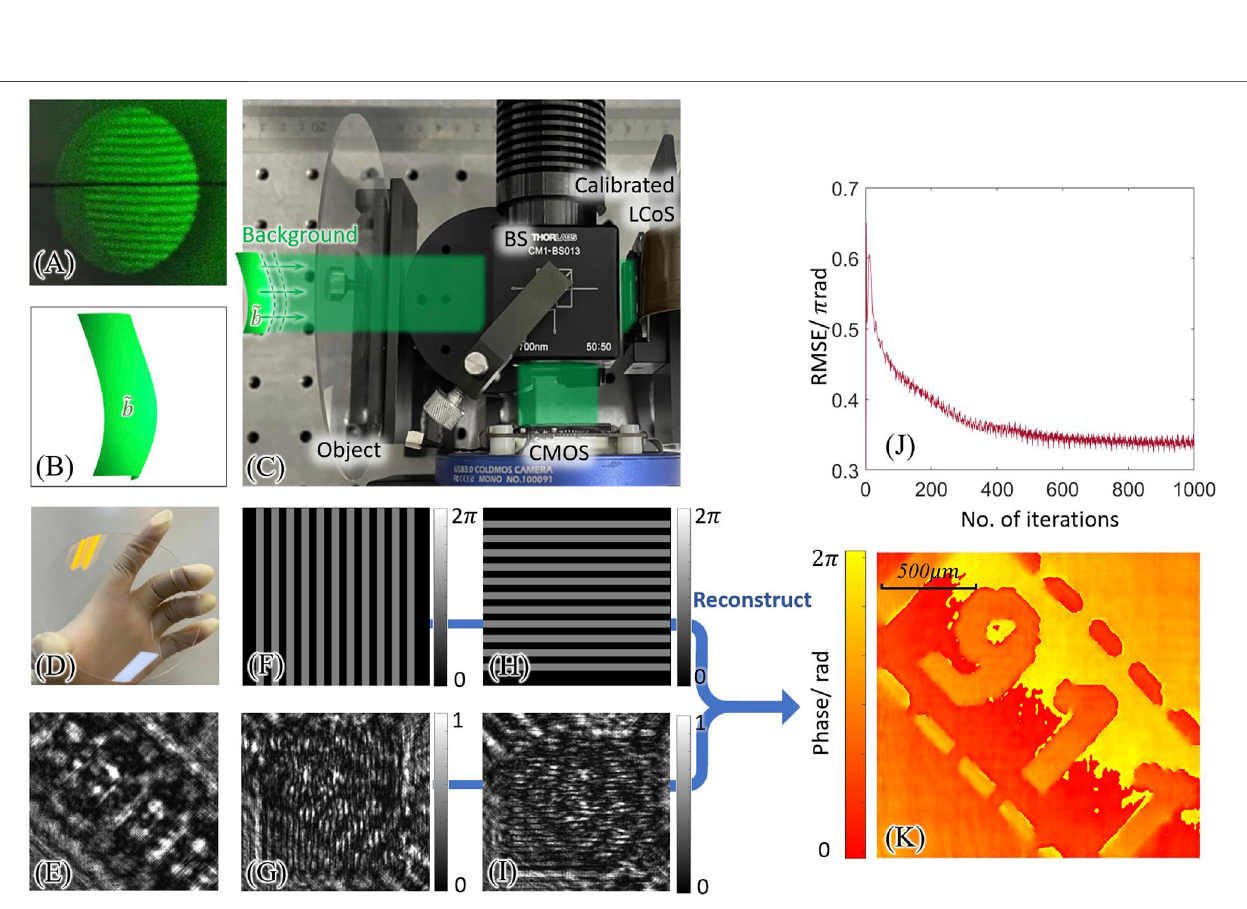
FIGURE6| Measuringaphaseobjectusingilluminationwithbackgroundphase. (A) Thefringepatternonashearinginterferometer(ThorlabsSI254)formeasuring thebackgroundwavefront. (B) Schematicoftheilluminationwithabackgroundphase. (C) Schematicofacoherentdiffraction imagingsetup. (D) Pictureoftheobject,a phase plate. (E) Diffraction pattern of the measured object. (F,H) : Two of the ASPM patterns in x - and y - direction. (G,F) : Captured intensities of the modulated wavefront. (J) The curve of the RMSE between the calculated wavefronts of adjacent iterations. (K) The reconstructed phase of the object with distortion in the